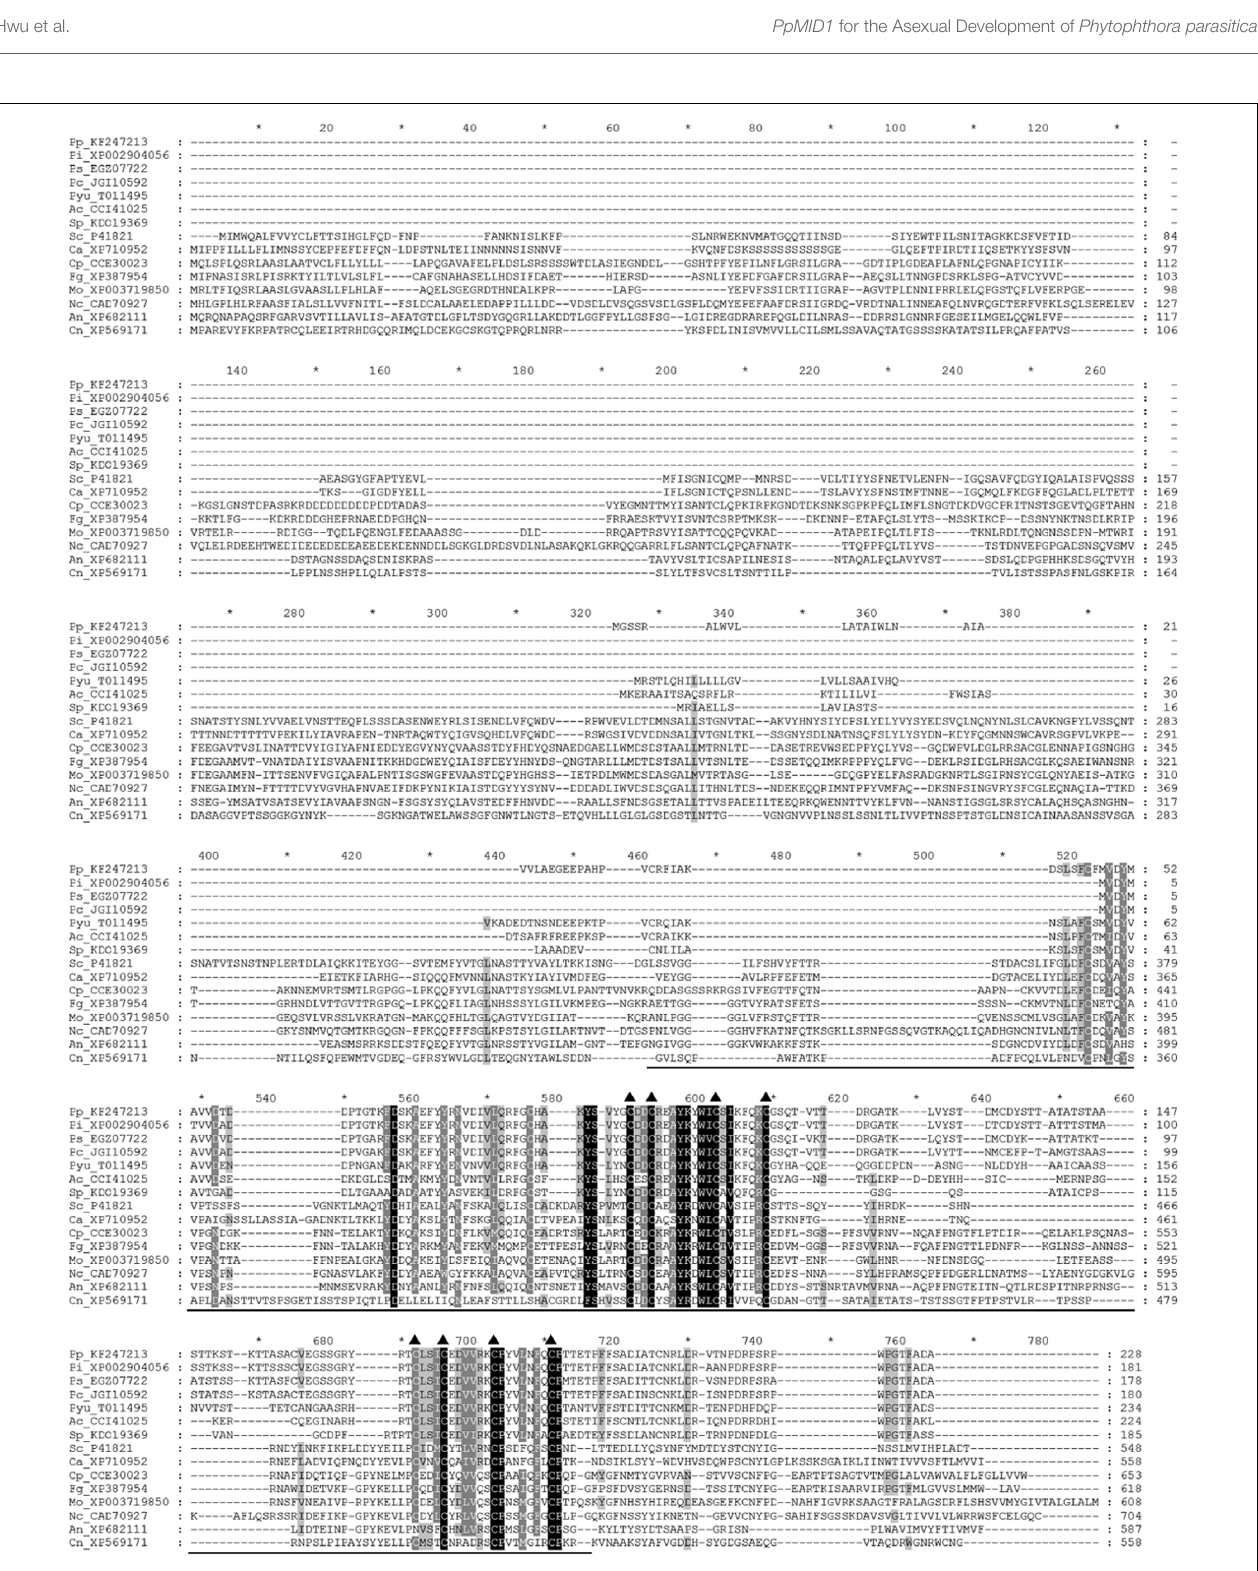
FIGURE 1 | Amino acid sequence alignment of PpMID1 and its homologs from other organisms. Amino acid sequences were aligned by using Clustal X 1.83. Triangles mark positions of the conserved cysteine residues and the underline indicates the location of the MID1 domain. Names of the sequences are shown with the first two letters representing the organisms, followed by GenBank accession numbers or JGI protein IDs. Ac, Albugo candida ; An, Aspergillus nidulans ; Ca, Candida albican ; Cn, Cryptococcus neoformans ; Cp, Claviceps purpurea ; Fg, Fusarium graminearum ; Mo, Magnaporthe oryzae ; Nc, Neurospora crassa ; Pc, Phytophthora capsici ; Pi, P. infestans ; Pp, P. parasitica ; Ps, P. sojae ; Pyu, Pythium ultimum ; Sc, Saccharomyces cerevisiae ; Sp, Saprolegnia parasitica.